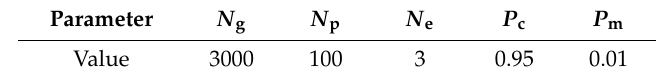
Table 5. Parameters of the